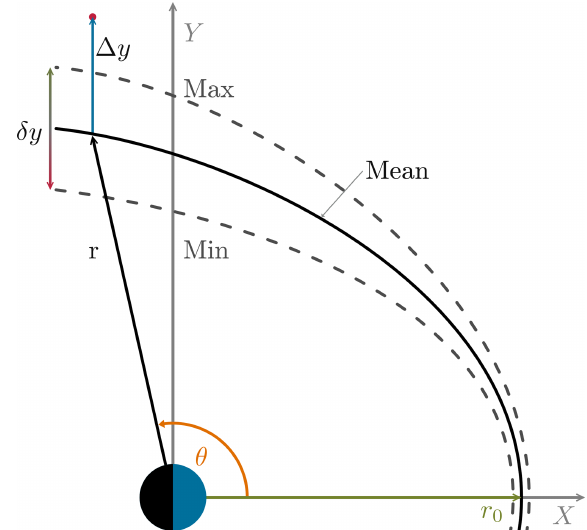
Figure 3. Scheme of the Shue et al. model and the normalization we use. The crossing of the MP with the x axis is the standoff distance r 0 . At certain angle θ the radial distance r of the MP is given. Fitting uncertainties by the model are indicated by the dashed lines. Not shown is the flaring effect α . To characterize the MP position (red dot) the difference distance along the y axis between model and data, (cid:49)y , is normalized by half the error range, δy (graphic is not to